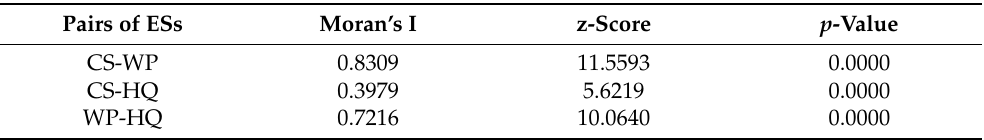
Table 4. Global Moran’s I of the TSD values between paired ESs.